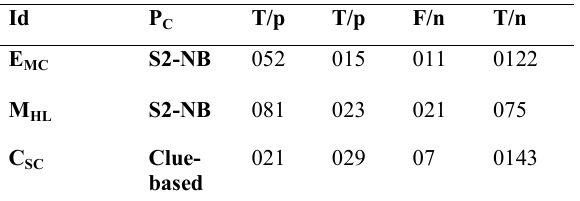
Table 2. Confusion Matrices on human